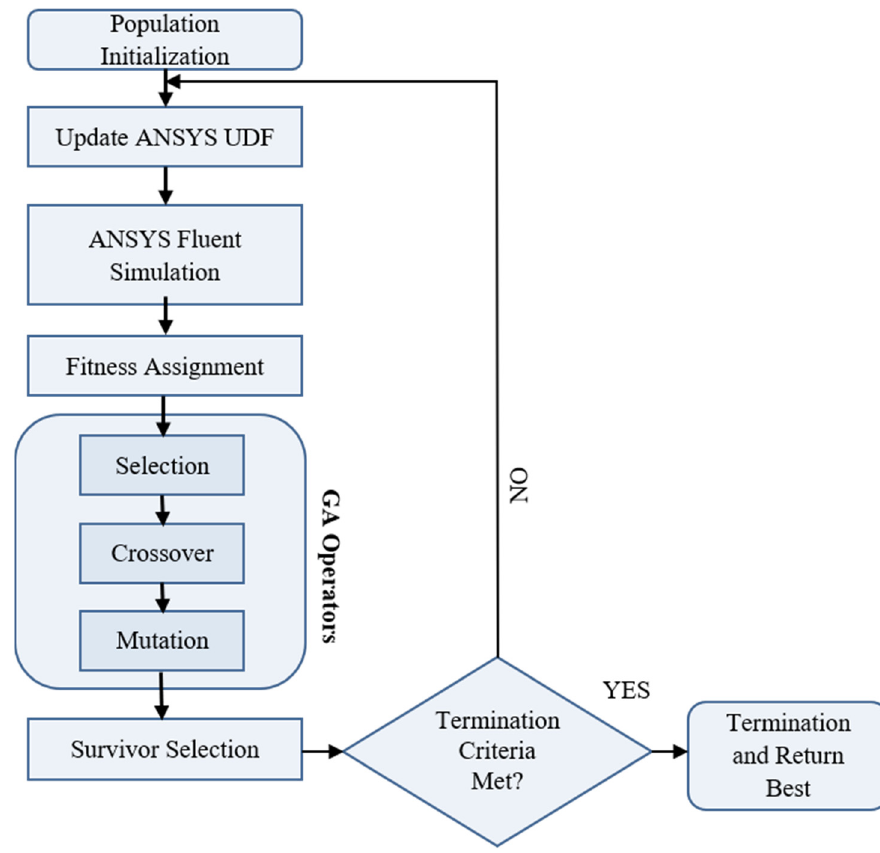
Figure 2. Flow chart of the genetic algorithm.